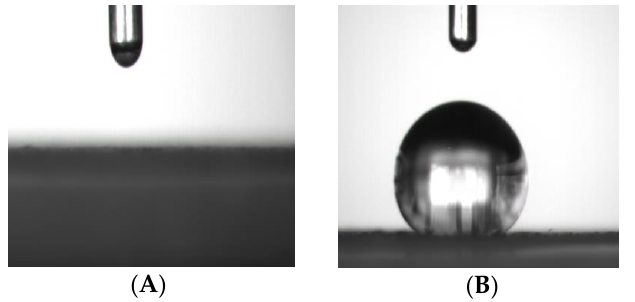
Figure 2. The graphs of water droplets after dripping on the surface of GO and vinyl-GO for 5 s. ( A ) The surface of GO; ( B ) the surface of vinyl − GO.